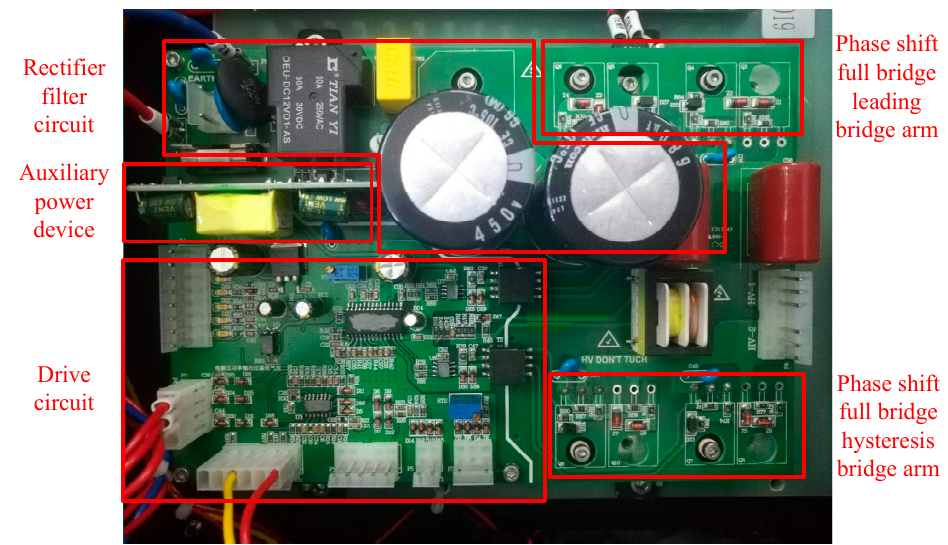
Figure 18. Main circuit board of resonant power supply system for plasma cleaning.